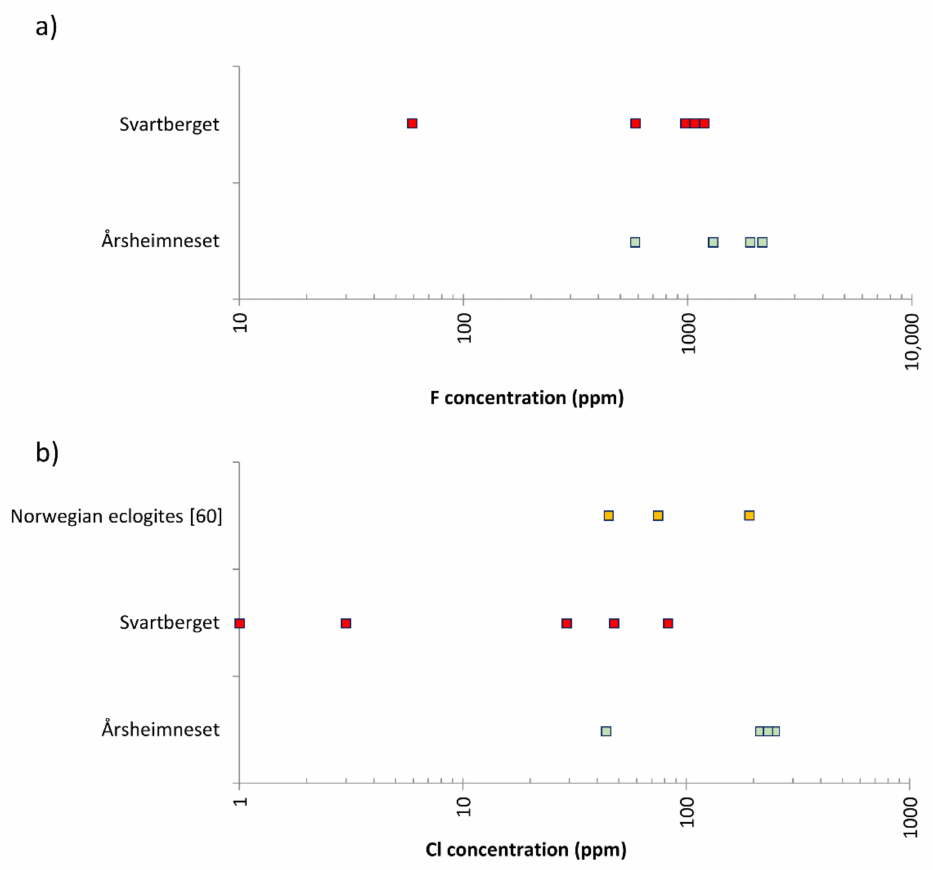
Figure 5. Comparison of bulk rock F ( a ) and Cl ( b ) ranges between Årsheimneset, Svartberget and the data of [60]. Table 2. Bulk rock data (major elements and F and Cl) for WGR samples, calculated using EPMA data and modal mineral